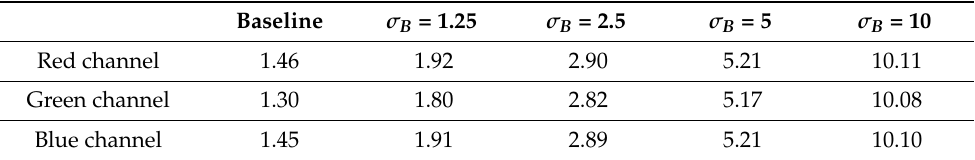
Table 2. The standard deviations of the resulting PSFs after applying 2D Gaussian kernels to the raw images on top of the inherent image PSF.